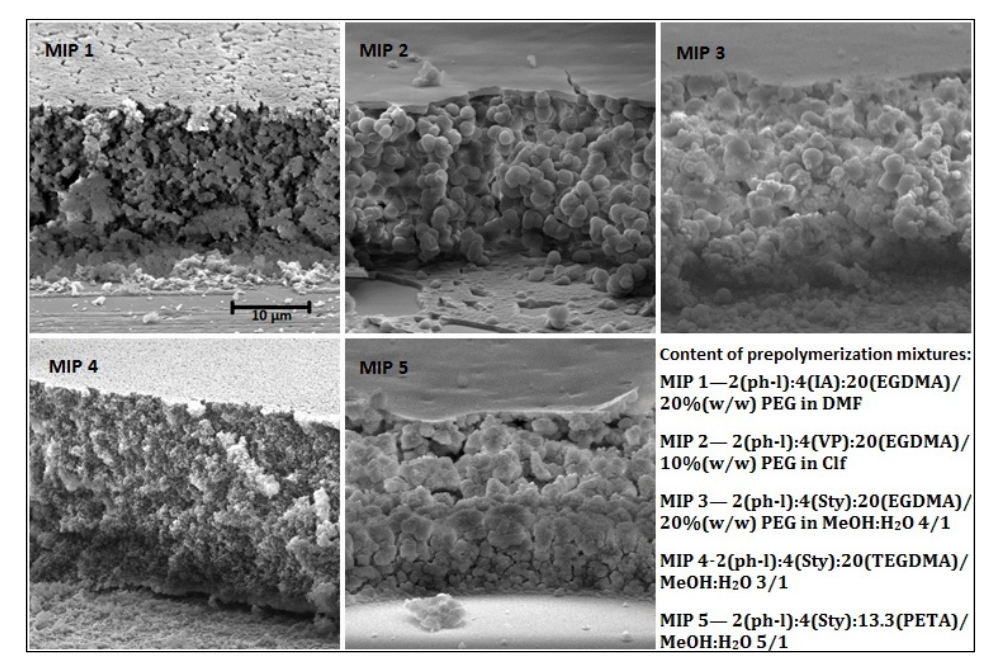
Figure 1. Top-down SEM images of MIP cross-sections.